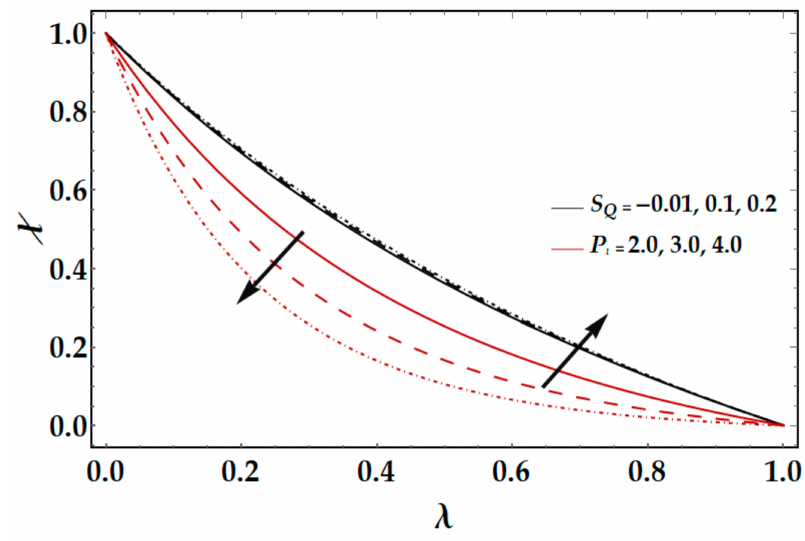
Figure 13. Implications of S Q , P l on motile microorganism density function χ ( λ )